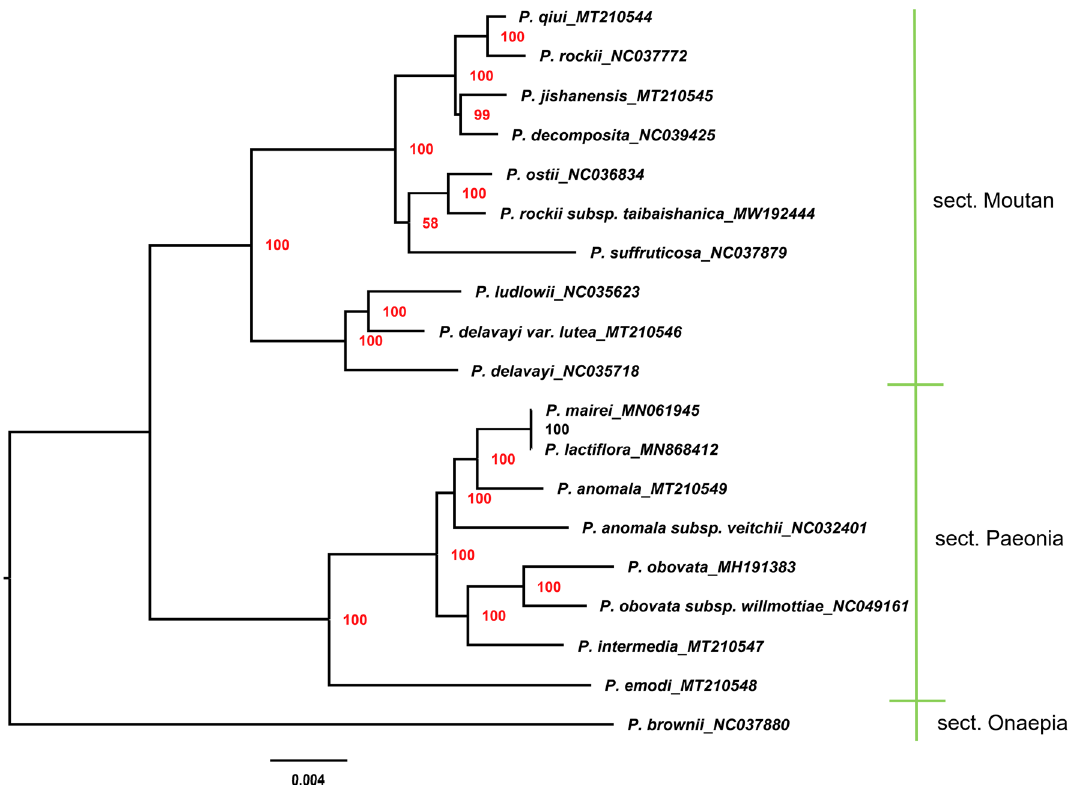
Figure 9. Phylogenetic tree constructed using Maximum Likelihood (ML) method based on SNPs of 19 Paeoniaceae species. Red numbers at nodes are values for bootstrap